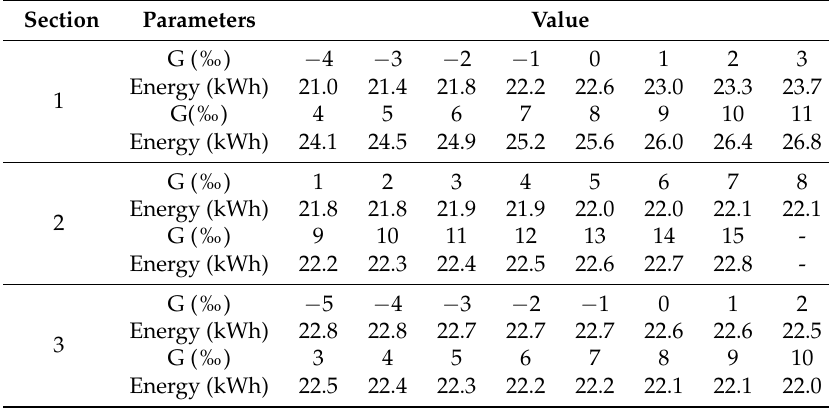
Table 8. Energy consumptions for different